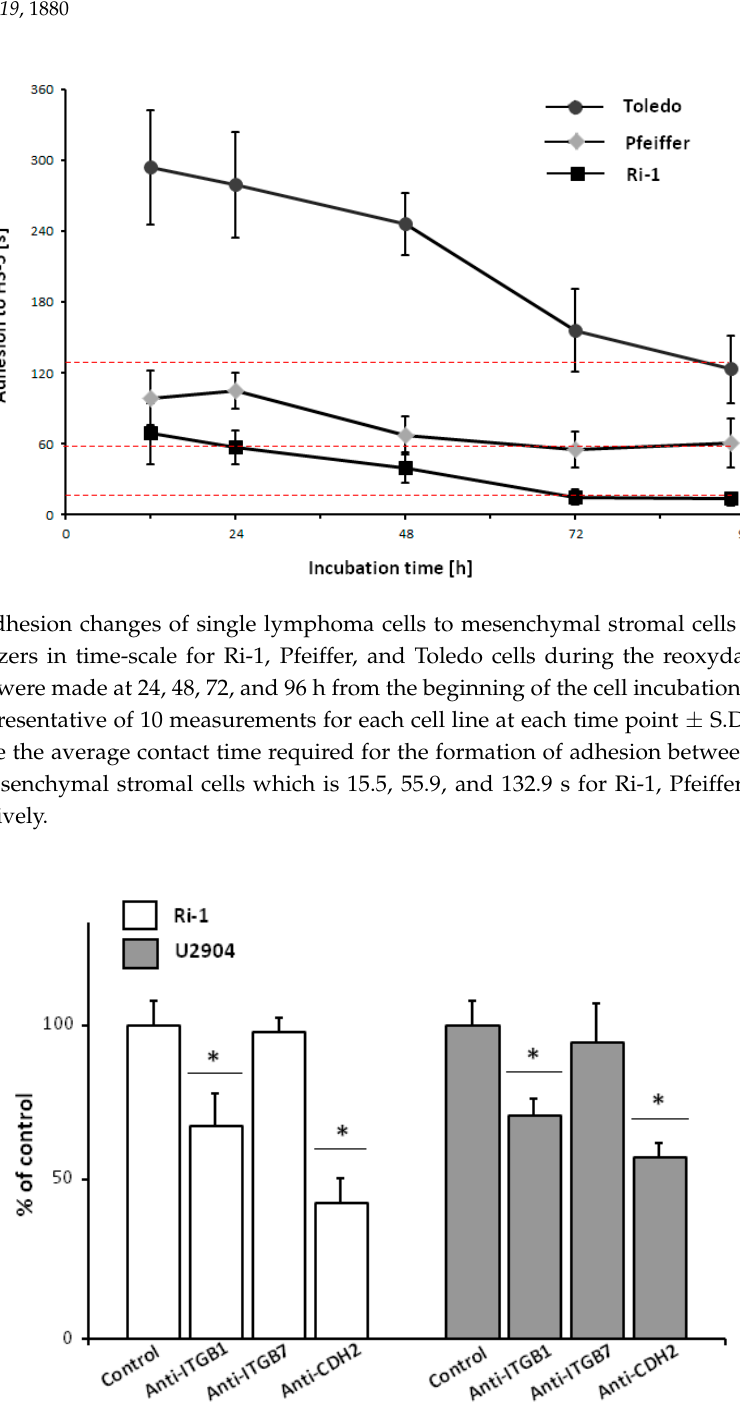
Figure 8. The adhesion molecules blocking study evaluated in optical tweezers. The examined cellular adhesion molecules (CAMs) are integrin β 1 (ITGB1), integrin β 7 (ITGB7), and cadherin-2 (CDH2). The percentage of lymphoma cells that stable bond to stromal cells within 40 and 300 s were calculated for Ri-1 and U2904 cell line, respectively. Data are expressed as mean ± SEM in tree independent experiments for 30 cells for each experimental condition. The symbol (*) indicates a significant difference in single cell adhesion after representative antibody treatment when compared to untreated cells considering a p -value < 0.001; Student’s t -test.